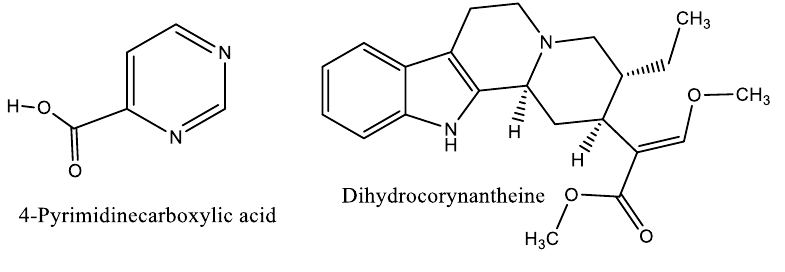
Scheme 1. Alkaloids of Coriaria nepalensis.